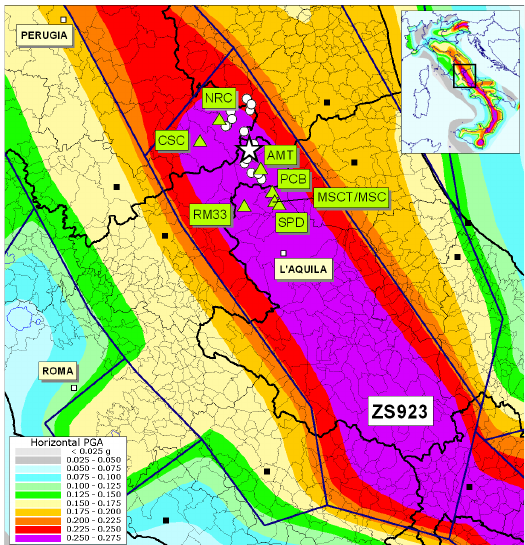
Figure 1. Seismic hazard map (MPS04) for Central Italy (top inset: map for whole Italy) in terms of horizontal PGA on rock with 10% probability of exceedance in 50 years. Epicenters of the 24 August 2016 main shock (white star) and events with Mw ≥ 4 (white dots) of the sequence in the first 40 days are also shown. Green triangles show the ac- celerometric stations considered in this study. Seismic source zones of the ZS9 model are indicated with blue lines.